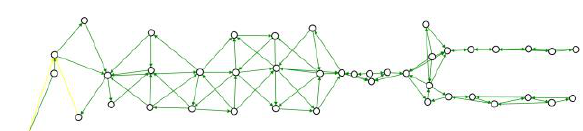
Figure 14. Case Study 2: results of pairwise plane-based